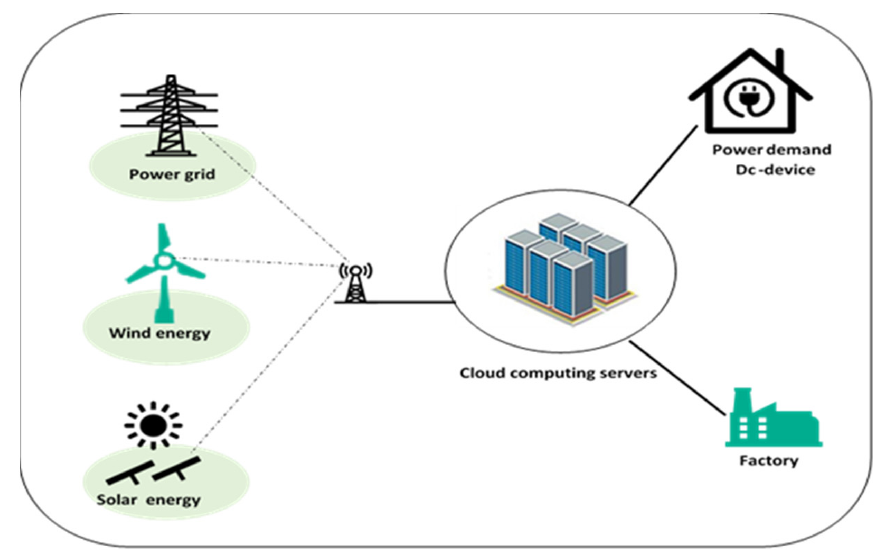
Figure 1. The schematic illustrates the smart energy system.